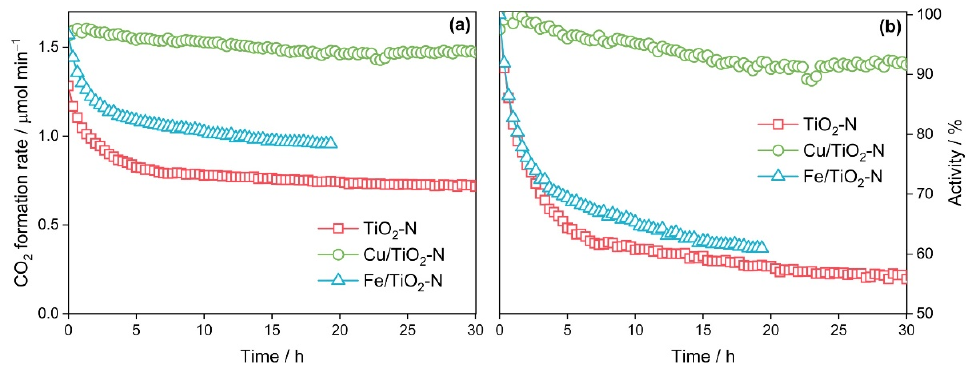
Figure 9. Effect of copper and iron species on the stability of TiO 2 -N (350 ◦ C) in absolute ( a ) and relative ( b ) coordinates.